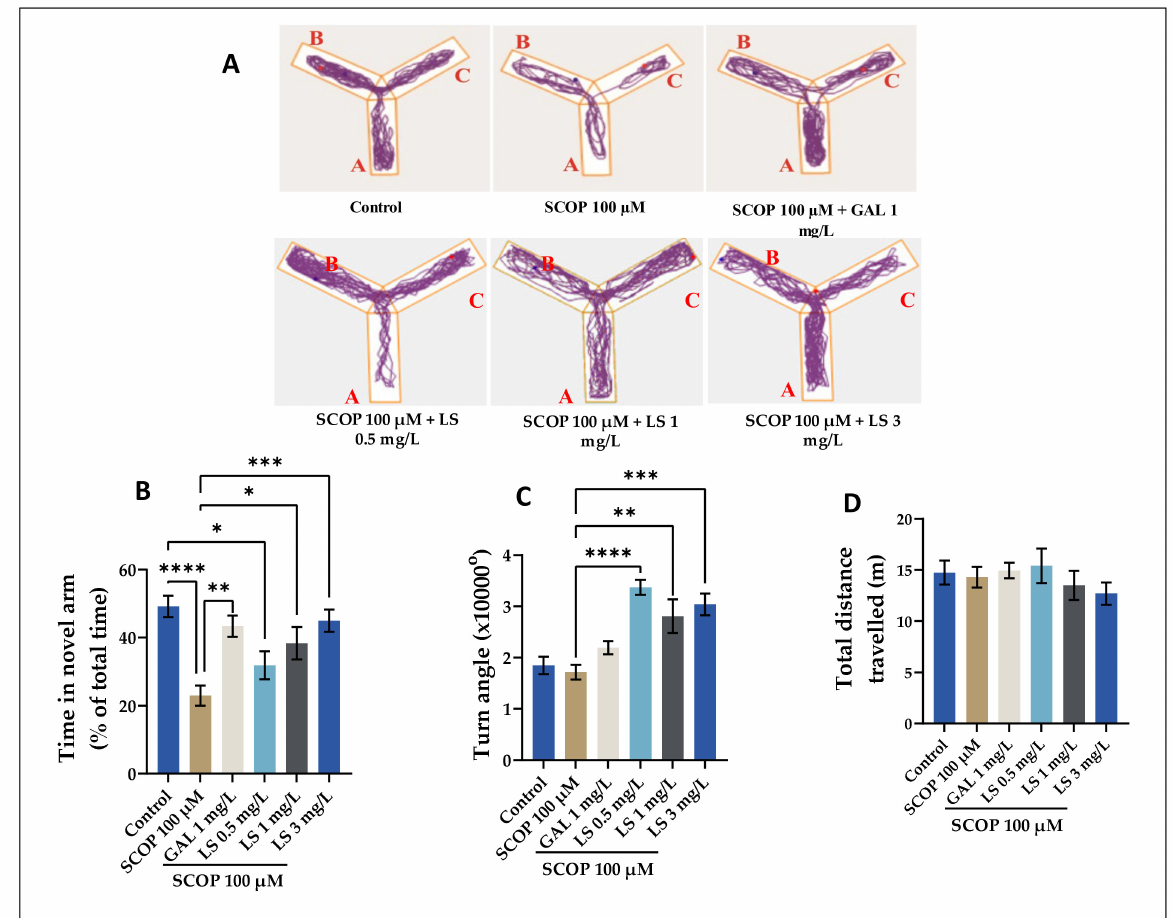
Figure 4. Lycopodium selago hydroethanolic extract (LS: 0.5, 1, and 3 mg/L) improved the locomotion pattern and memory in the Y-maze test. ( A ) Representative locomotion-tracking pattern of the control, scopolamine (SCOP 100 µ M), Lycopodium selago (LS: 0.5, 1, and 3 mg/L) and galantamine (GAL: 1 mg/L) treated groups. ( B ) Representation of the total time spent in the novel arm in different groups. ( C ) Representation of the turn angle of zebrafish in the tank in different groups. ( D ) Representation of the total distance traveled by zebrafish in the tank in different groups. Values are means ± S.E.M. ( n = 10). For Tukey’s post-hoc analyses: **** p < 0.0001, *** p < 0.001, ** p < 0.01, and * p <